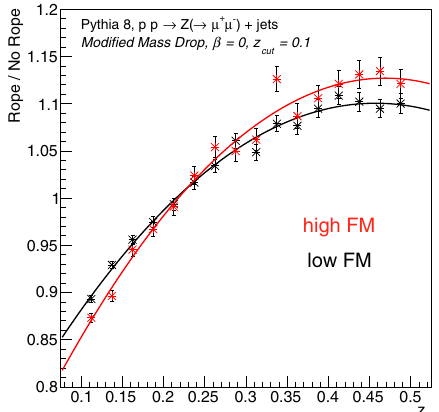
Fig. 12 The quadratic fits to the low- and high-multiplicity Rope/No Rope z g spectra shown for FM in Fig.